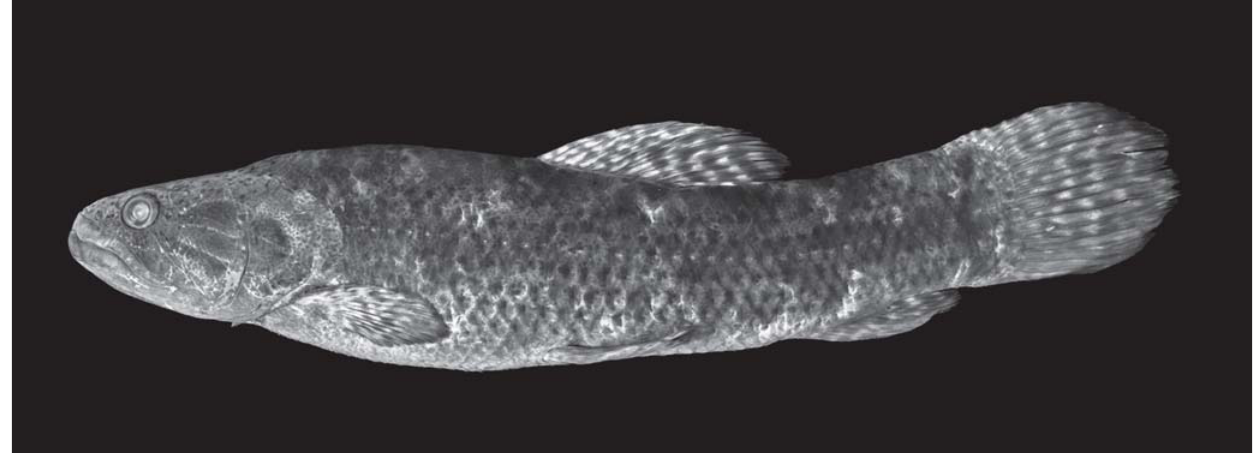
Fig. 2. Hoplias australis , holotype, MCP 40175, 220 mm SL, rio das Antas, Formosa do Sul, Santa Catarina State, Brazil.